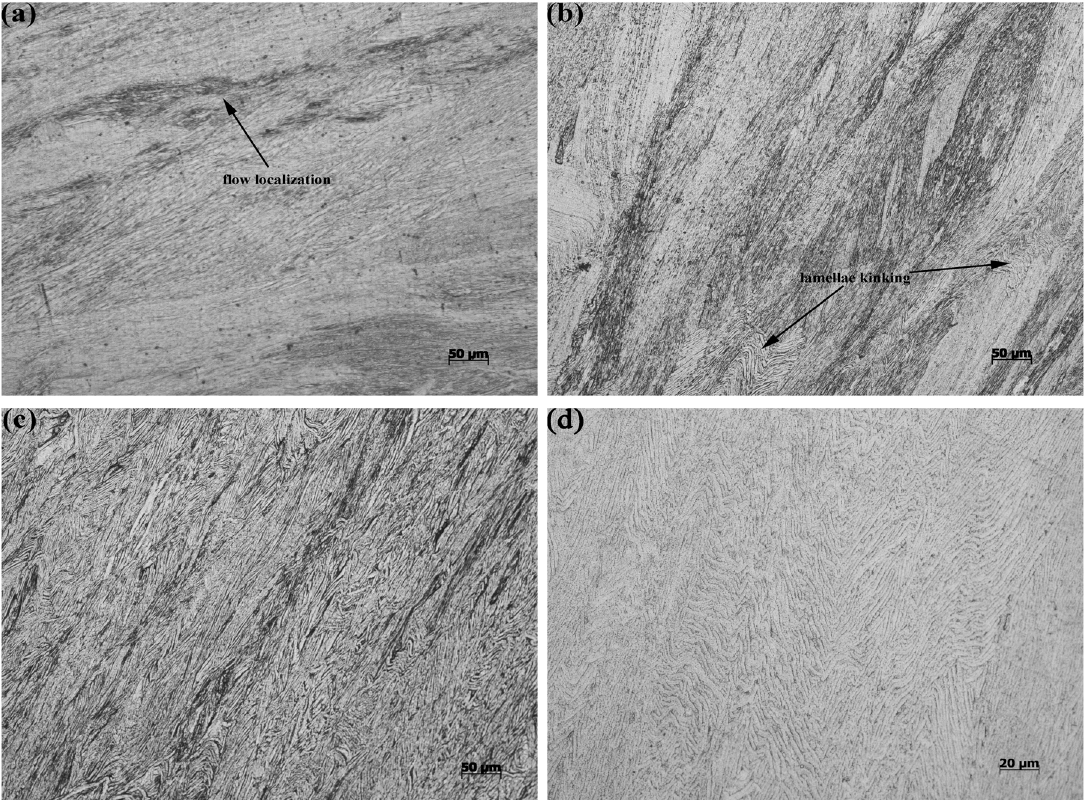
Figure 10: Microstructures of Ti-6Al-4V-0.1Ru at strain of 0.9 and the deformation conditions of (a) 1073 K & 1 s -1 ; (b) 1073 K & 0.1 s -1 ; (c) 1123 K & 1 s -1 and (d) 1123 K & 10 s -1 .